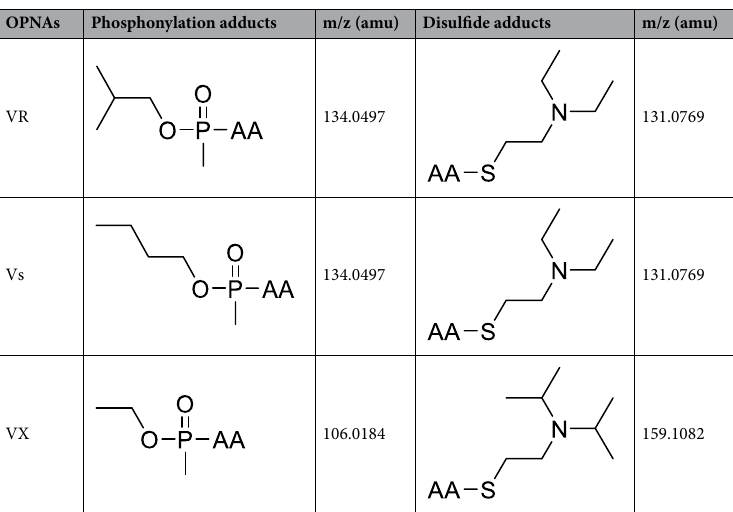
Table 6. Characteristic ions of the structure of V-type OPNAs in albumin